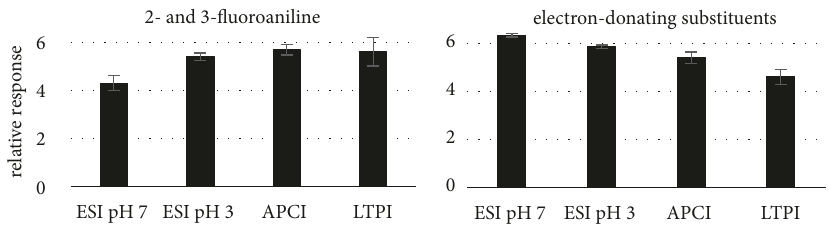
Figure11:Responsepatternof2-and3-fluoroanilinesvs.electron-donatingsubstitutedcompoundsoverthefourionizationconditionsreflect the fact that ESI pH 7 response is dominated by solution basicity while this advantage is lost when it comes to conditions where volatility of the compound matters.